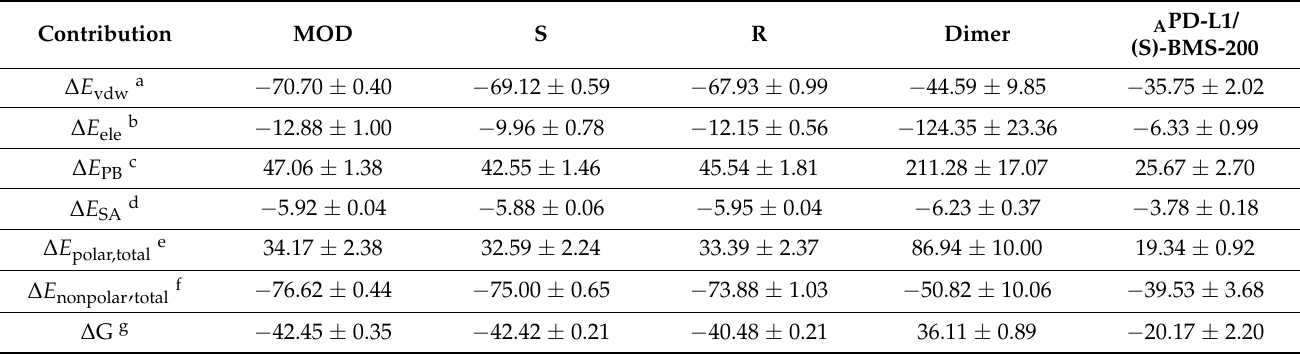
Table 1. Binding free energies in the MOD, S, R, dimer and A PD-L1/(S)-BMS-200 systems